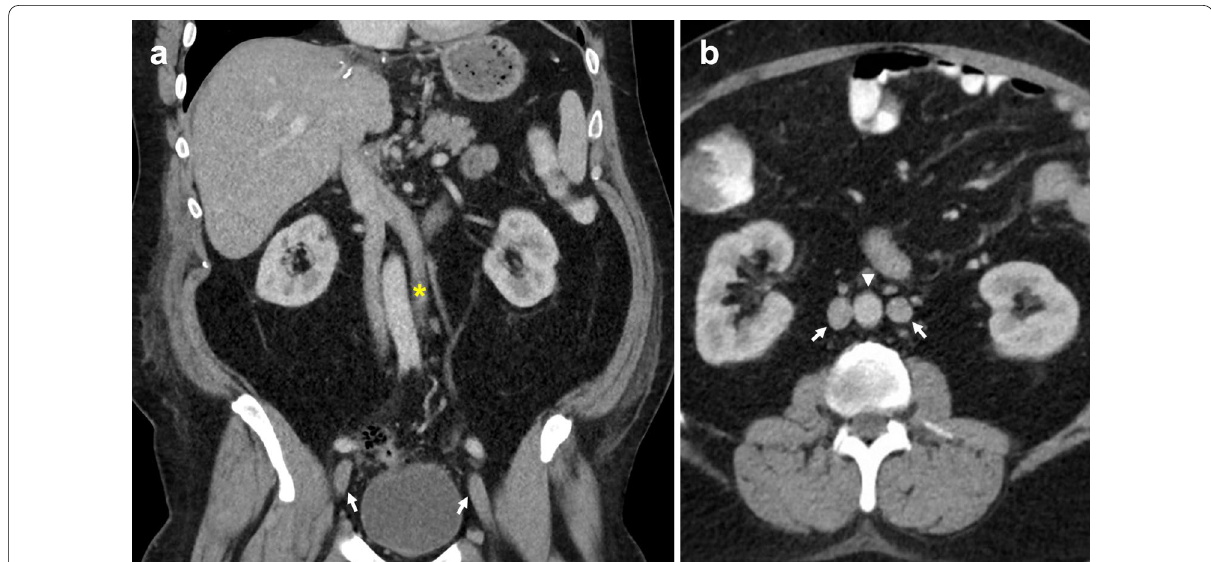
Fig. 3 Duplicated IVC with symmetrical caliber. a Contrast-enhanced coronal CT shows a duplicated IVC (asterisk) with symmetrical caliber draining into the suprarenal IVC. Bilateral external iliac veins (arrows) both drain into cavae on their respective sides. b Axial CT image shows the paired IVC trunks (arrows) positioned on either side of the abdominal aorta (arrowhead)